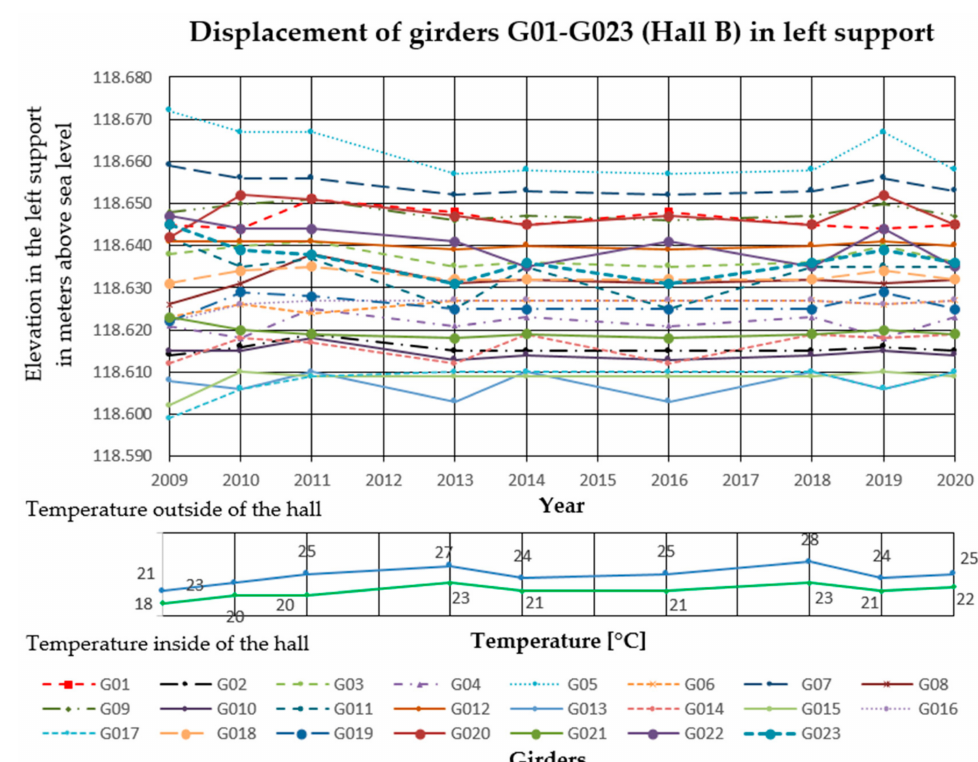
Figure 11. Displacement of the left side of the girders in Hall